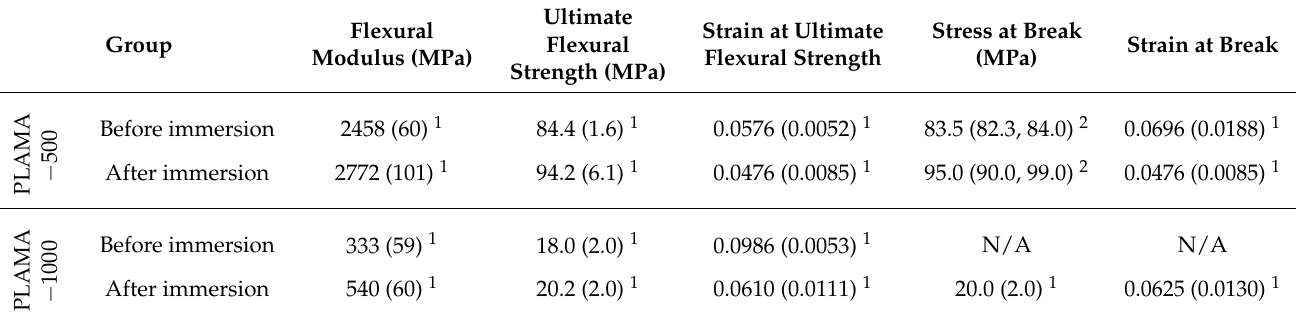
Table 8. Changes in the flexural properties of materials after the SBF immersion test.